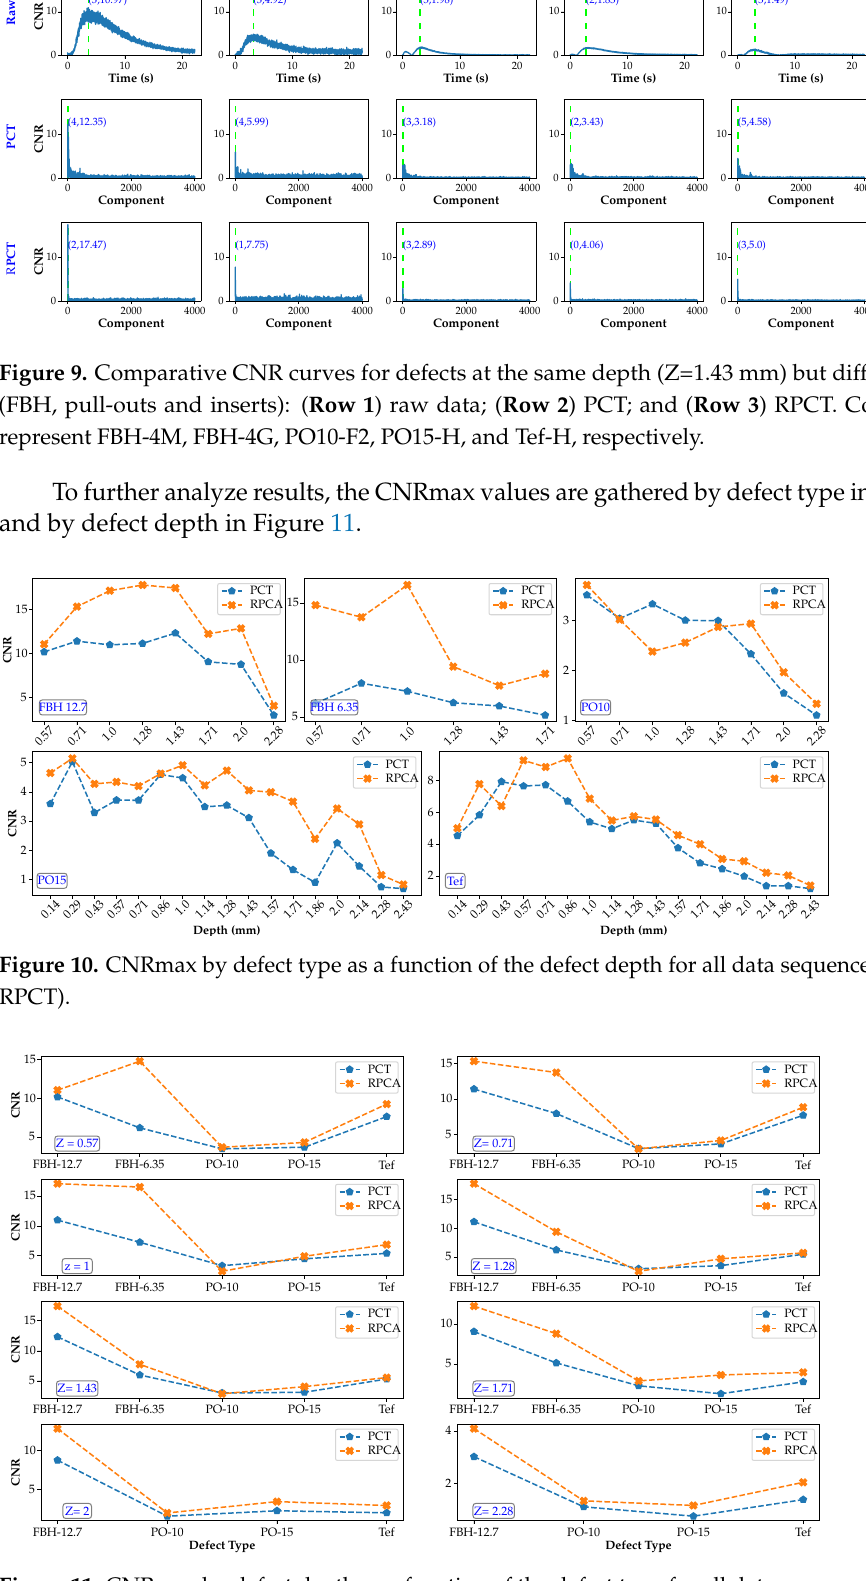
Figure 11. CNRmax by defect depth as a function of the defect type for all data sequences (PCT and